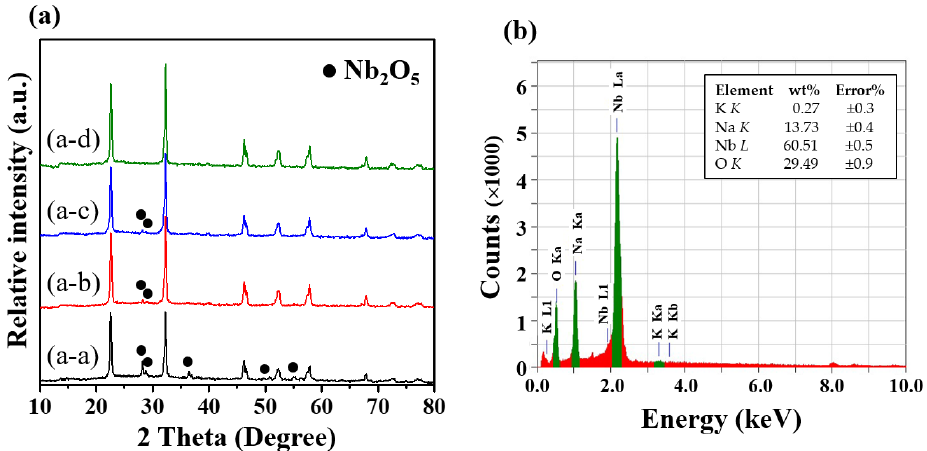
Figure 3. ( a ) XRD patterns of KNN particles synthesized in glycothermal conditions at 200 ◦ C with various reaction times. (a-a) 1 h, (a-b) 3 h, (a-c) 6 h, and (a-d) 12 h. JCPDS database for Nb 2 O 5 (JCPDS card 30-0873) and NaNbO 3 (JCPDS card 73-0803) are also included in the figure. ( b ) EDS analysis of KNN particles synthesized at 200 ◦ C for 12